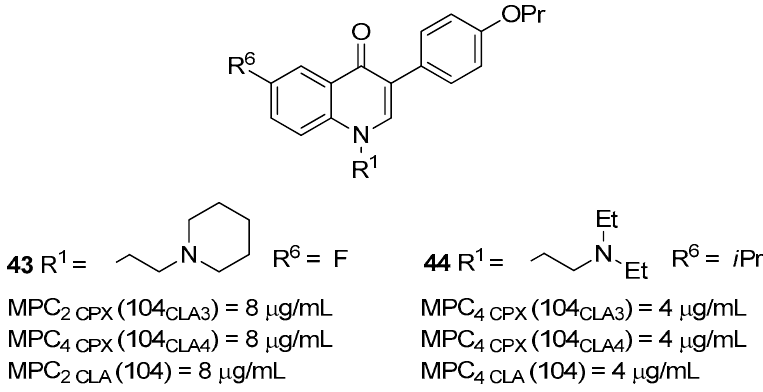
Figure 16. 3-phenylquinolones as NTM EPIs.